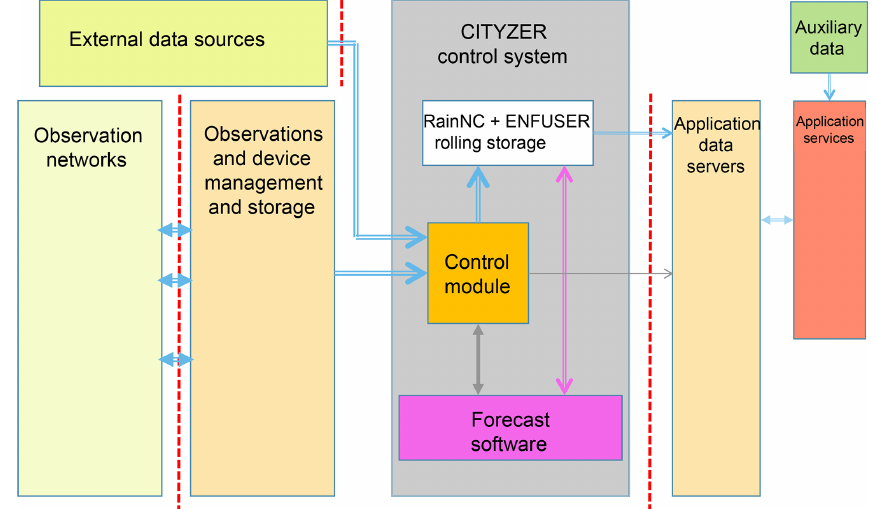
Figure 2. System architecture, module